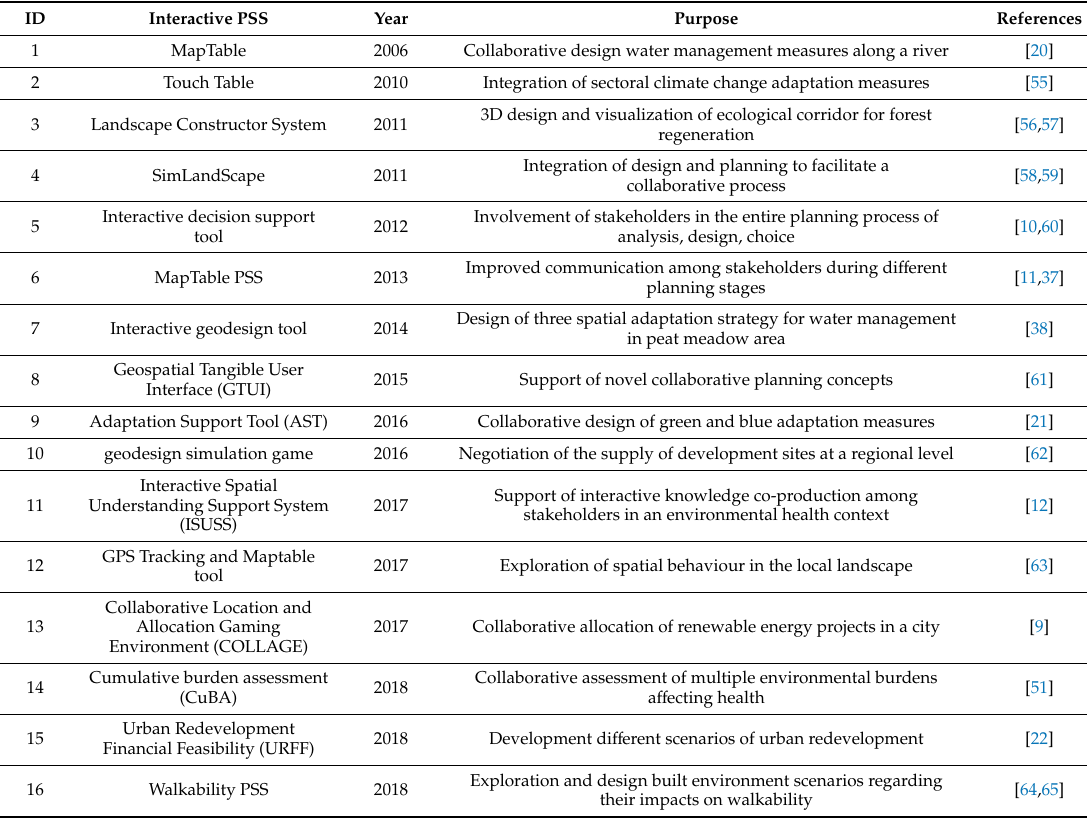
Table 2. Studies to be included in the